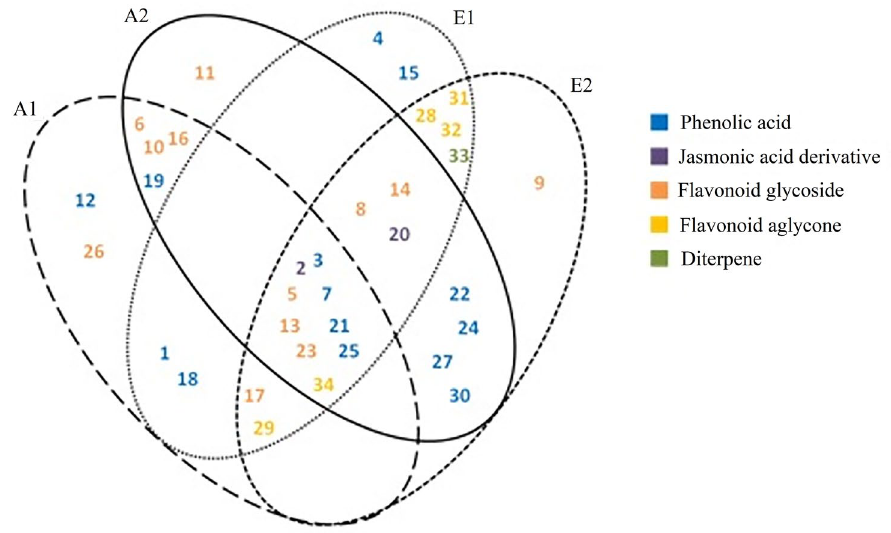
Figure 1. Distribution of the identified constituents ( 1 – 34 ) in aqueous and ethyl acetate extracts of stems, leaves and ( 29 ), Hydroxycinnamic acid hexamer ( 30 ), Naringenin ( 31 ), Apigenin ( 32 ), Rosmanol /isomer ( 33 ), Genkwanin ( 34 ).